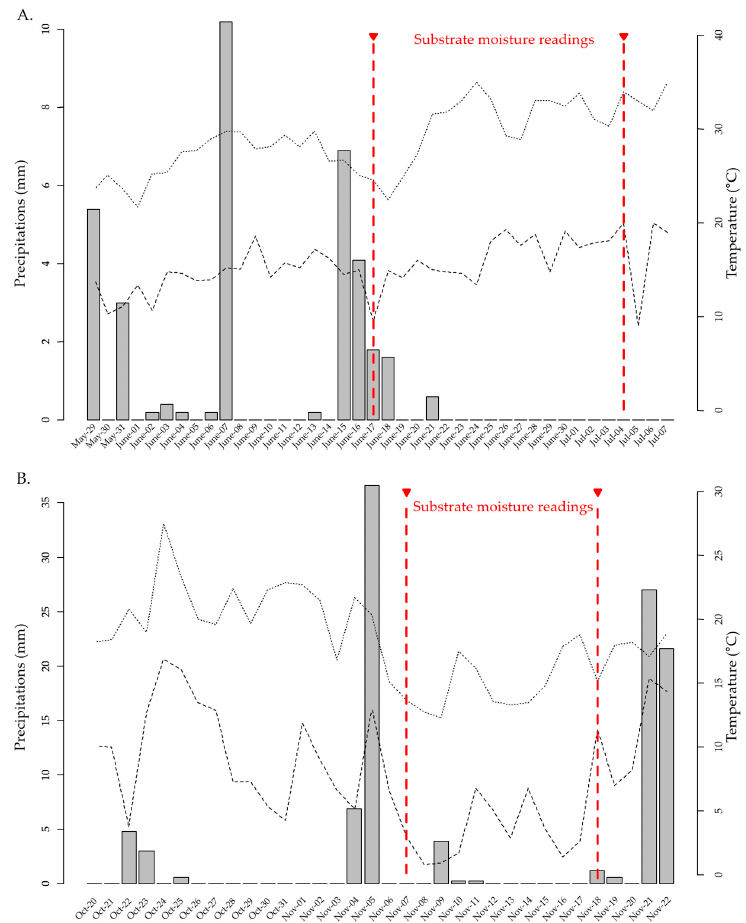
Figure 3. Periods of surveys in June ( A ) and November ( B ) 2016 as related to periods of precipitation preceding the experimentation on the roof of Avignon Technology Institute (IUT) (Southeastern France). Lines represent minimum and maximum temperatures and bars represent precipitation.